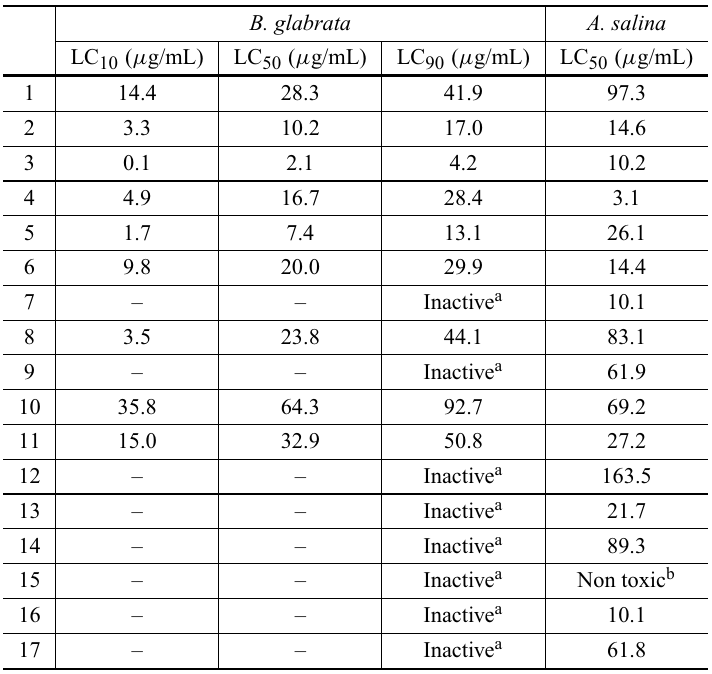
Molluscicidal activity ( µ g/mL) of lawsone and derivatives on B. glabrata and toxicity against Artemia salina